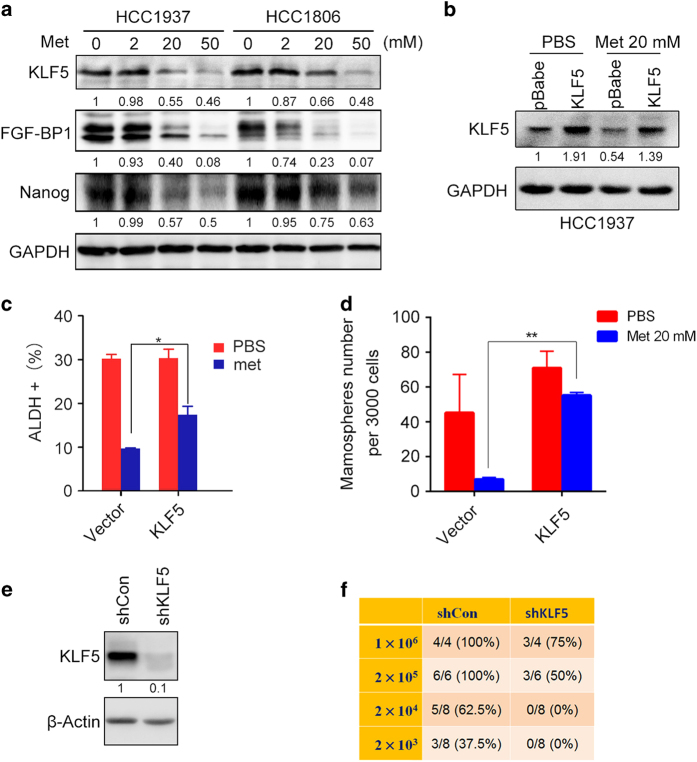
Metformin suppresses TNBC stem cells partially through the downregulation of KLF5 expression. (a) Metformin inhibited the expression of KLF5 and its downstream target genes, FGF-BP1 and Nanog, in both HCC1937 and HCC1806 cells. Protein expression was examined by WB analysis. The cells were treated with 2, 20 or 50 mM metformin for 24 h. Glyceraldehyde 3-phosphate dehydrogenase (GAPDH) was used as the loading control. Normalized band densities were shown below each band. No metformin treatment was defined as 1. (b) pBabe-KLF5 or vector (pBabe) plasmids were transfected into HCC1937 cells for 48 h. The cells were then treated with either metformin (20 mM) or PBS for another 24 h, and the expression of KLF5 was detected by using the WB. (c) KLF5 overexpression partially but significantly rescued the metformin-induced CSC reduction in HCC1937 cells as measured by the ALDH assay. The statistical significance was determined by Student’s t-test. *P<0.05. (d) KLF5 overexpression significantly rescued metformin-induced CSC reduction in HCC1937 cells as measured by the mammosphere assay. The statistical significance was determined by Student’s t-test. **P<0.01. (e) Stable knockdown of KLF5 in HCC1806. The expression of KLF5 was tested by WB. β-Actin was used as the loading control. (f) Knockdown of KLF5 inhibited CSCs according to the limited dilution assay. Stable knockdown of KLF5 cells (shKLF5) and control cells (shCon) were seeded into nude mice. The incidence of tumors is listed according to cell numbers that were seeded.